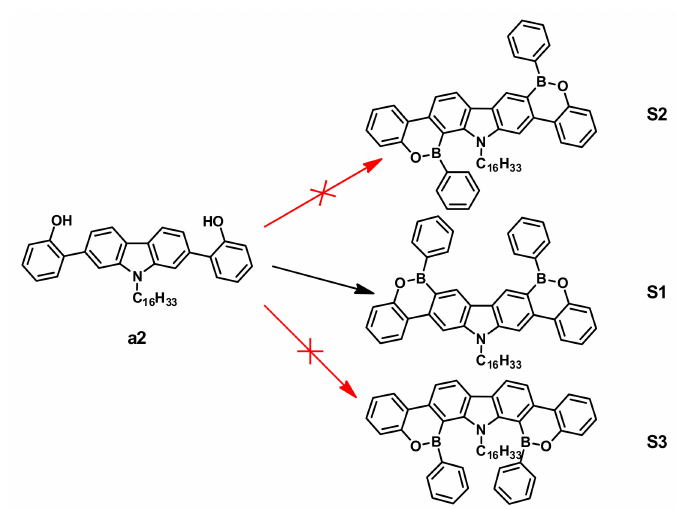
Scheme 2. Synthetic route to compound S1.